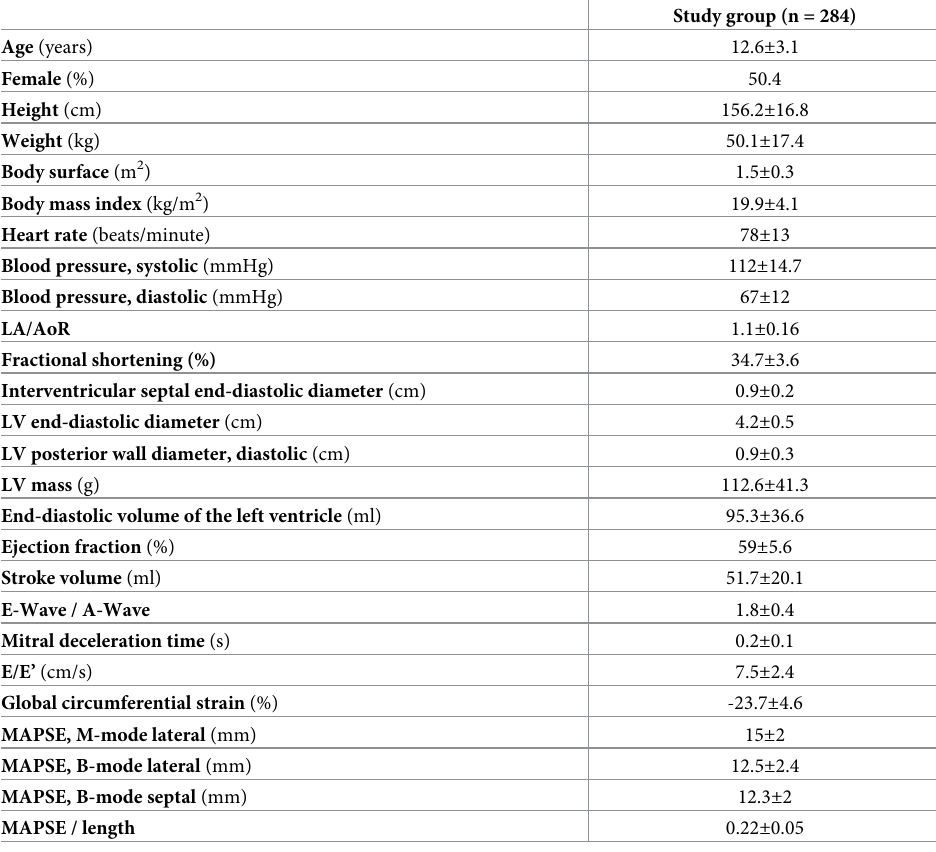
Table 1. Baseline clinical characteristics and echocardiographic parameters derived from two-dimensional and Doppler